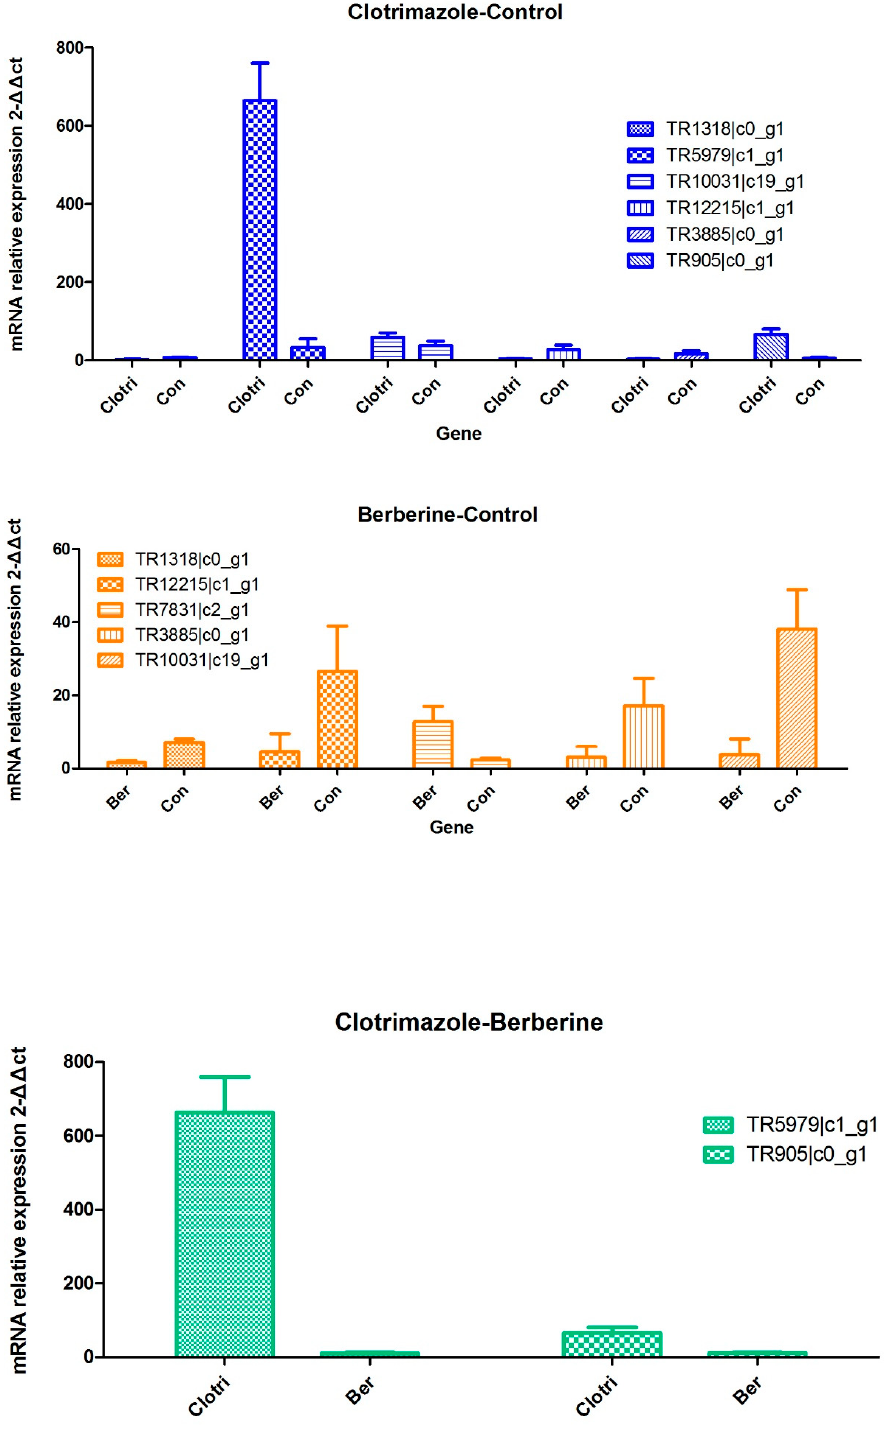
Figure 8. Quantitative real-time RT-PCR (qRT-PCR) was used to assess 7 selected genes (TR1318|c0_g1, Accumulation-associated protein; TR5979|c1_g1, Putative fungistatic metabolite; TR10031|c19_g1, Multidrug resistance protein CDR2; TR12215|c1_g1, Cholesterol 7-alpha-monooxygenase; TR3885|c0_g1, Accumulation-associated protein; TR905|c0_g1, Putative ankyrin repeat protein; TR7831|c2_g1, ABC transporter B family member) to validate transcriptome data obtained for Trichophyton mentagrophytes treated with berberine chloride or